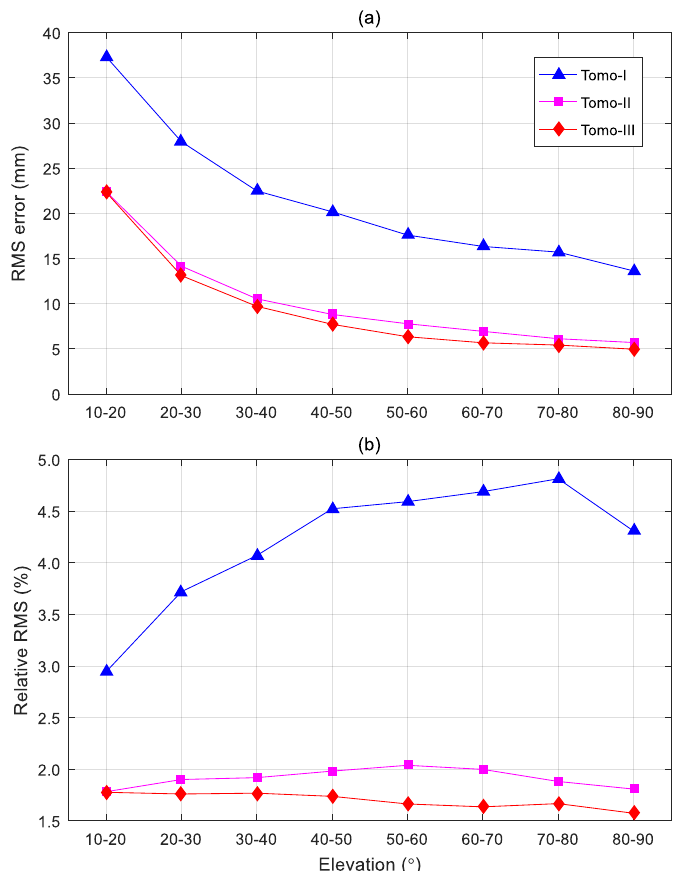
Figure 4. Change of the ( a ) RMS errors and ( b ) relative RMS with elevation for slant wet delay (SWD) comparisons between GPS and tomography. Table 1. Biases and RMS errors of the differences between GPS-estimated SWDs and tomographic SWDs using schemes Tomo-I, Tomo-II, and Tomo-III.